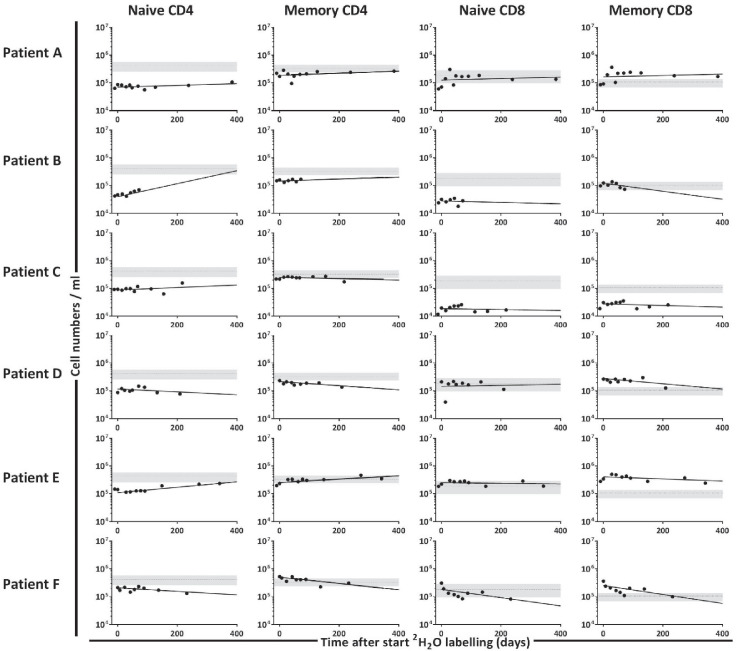
Best fits of T-cell numbers in autologous hematopoietic stem cell transplantation (autoHSCT) patients.Best ﬁts (black lines) to the normalized cell numbers data (black dots). Absolute numbers (cells per milliliter of blood) of naive (CD27+CD45RO-) and memory (CD45RO+) CD4+ and CD8+ T-cells were corrected for noise as described in Materials and methods. The median cell numbers (dotted gray line) and the corresponding IQR (interquartile range, gray area) for healthy controls are shown.